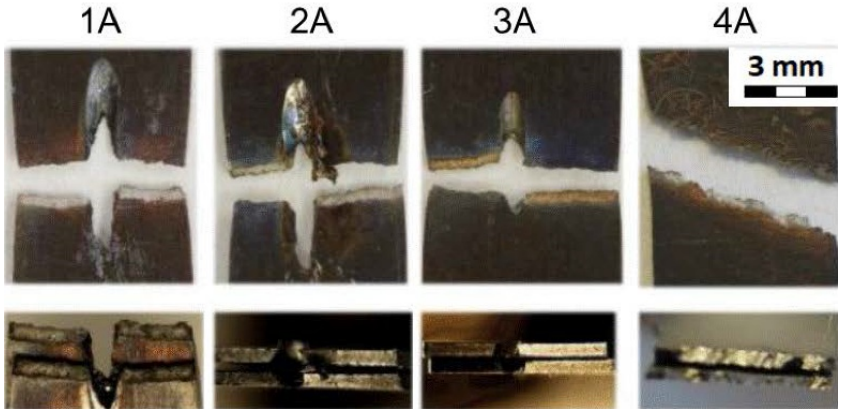
Table 10. Average values of mechanical properties—Inconel 718; material thickness 1.0 mm; tests at elevated temperature.